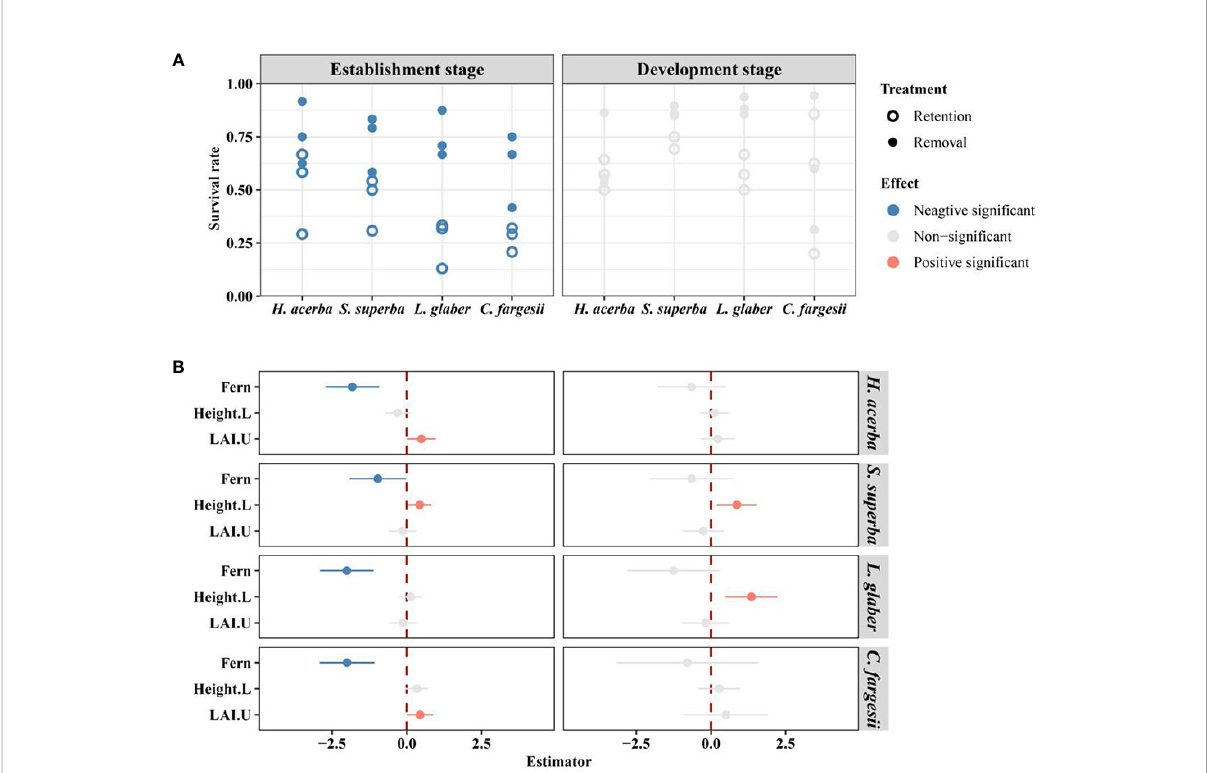
FIGURE 2 The difference in survival rate of seedlings between retention and removal treatments in establishment and development stages (A) , and the corresponding estimator of explanatory variables in generalized linear mixed-effects models (B) . Fern in B refers to the effect of retention treatment vs removal treatment; Height.L refers to the log-transformed height of seedling in the last census; LAI.U is the leaf area index of the plot in the understory. The error bars in B represent 1.96*se around estimator in generalized linear mixed models. Blue and red points in B indicate parameter estimates signi fi cantly different from zero at the alpha = 0.05